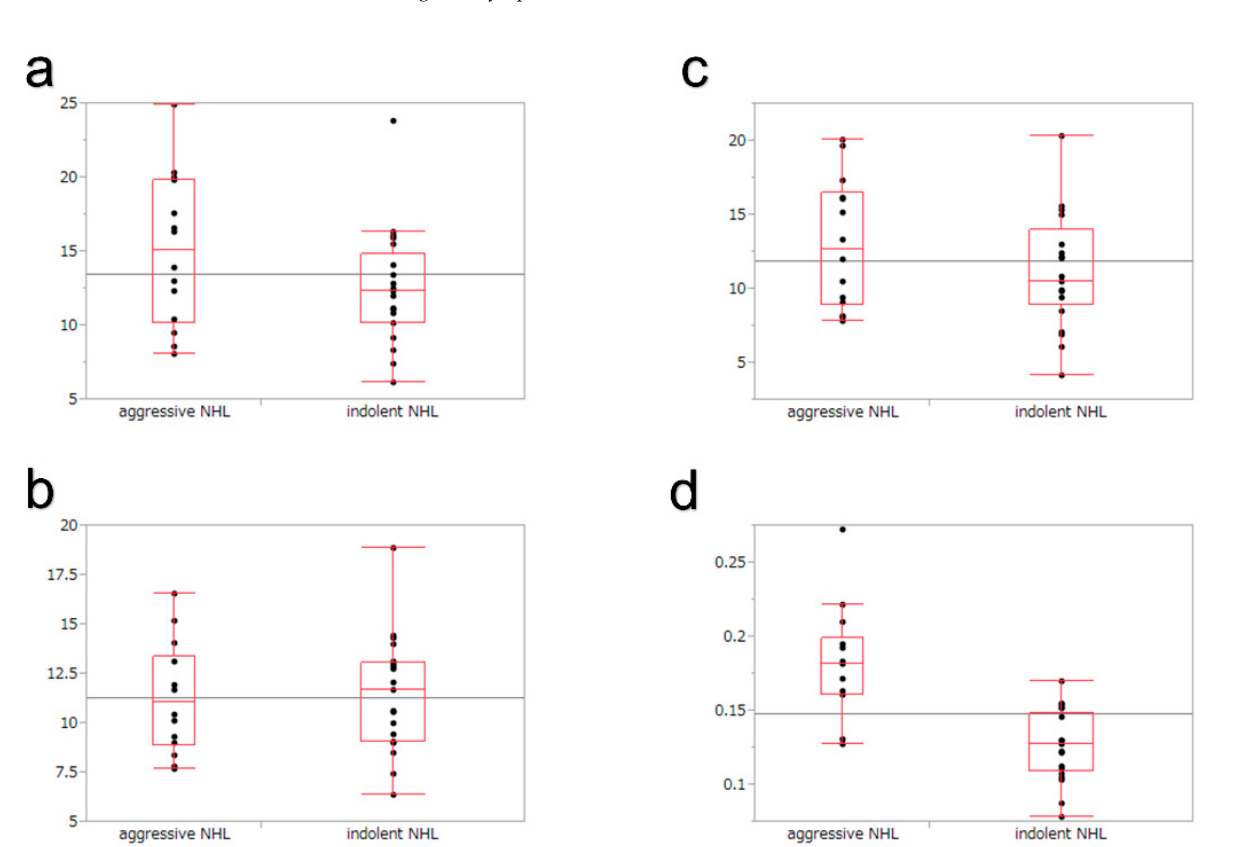
Figure 4. Comparison of indolent and aggressive non-Hodgkin’s lymphomas in lesions with homo- geneous enhancement by time–intensity curve (TIC) analysis. TIC parameters are as follows; ( a ) time to maximum intensity, ( b ) maximum intensity, ( c ) intensity gain, ( d ) velocity of reduction.